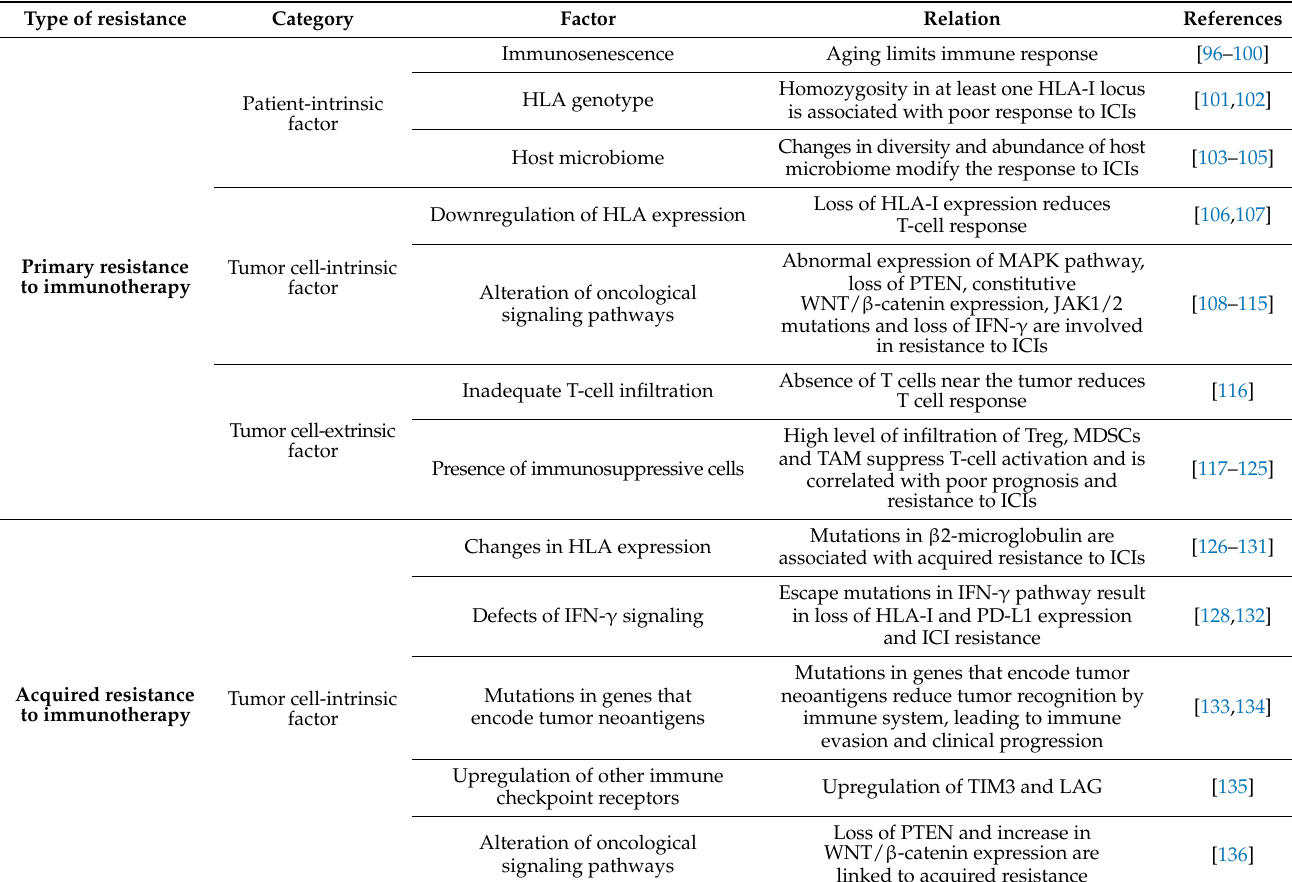
Table 2. Mechanisms of resistance to